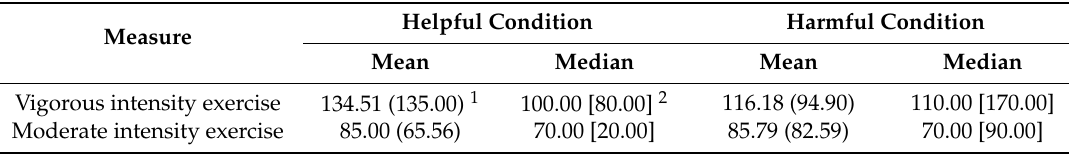
Table 2. Weekly exercise demographics by experimental group (minutes per